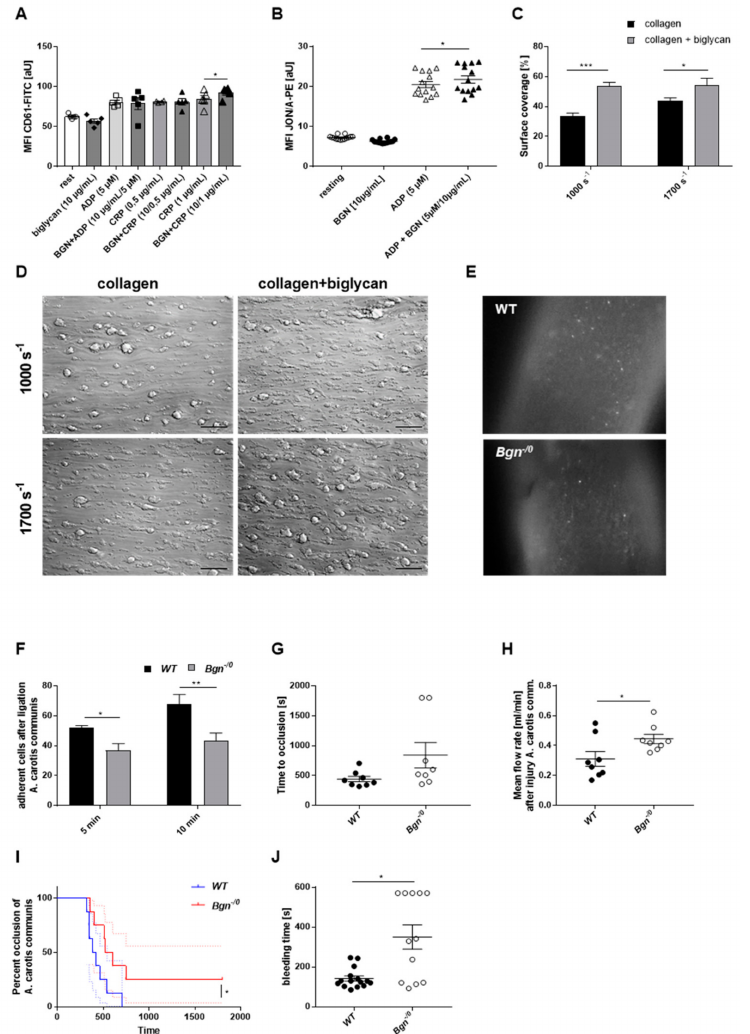
Figure 4. The presence of biglycan induced elevated murine platelet activation and thrombus